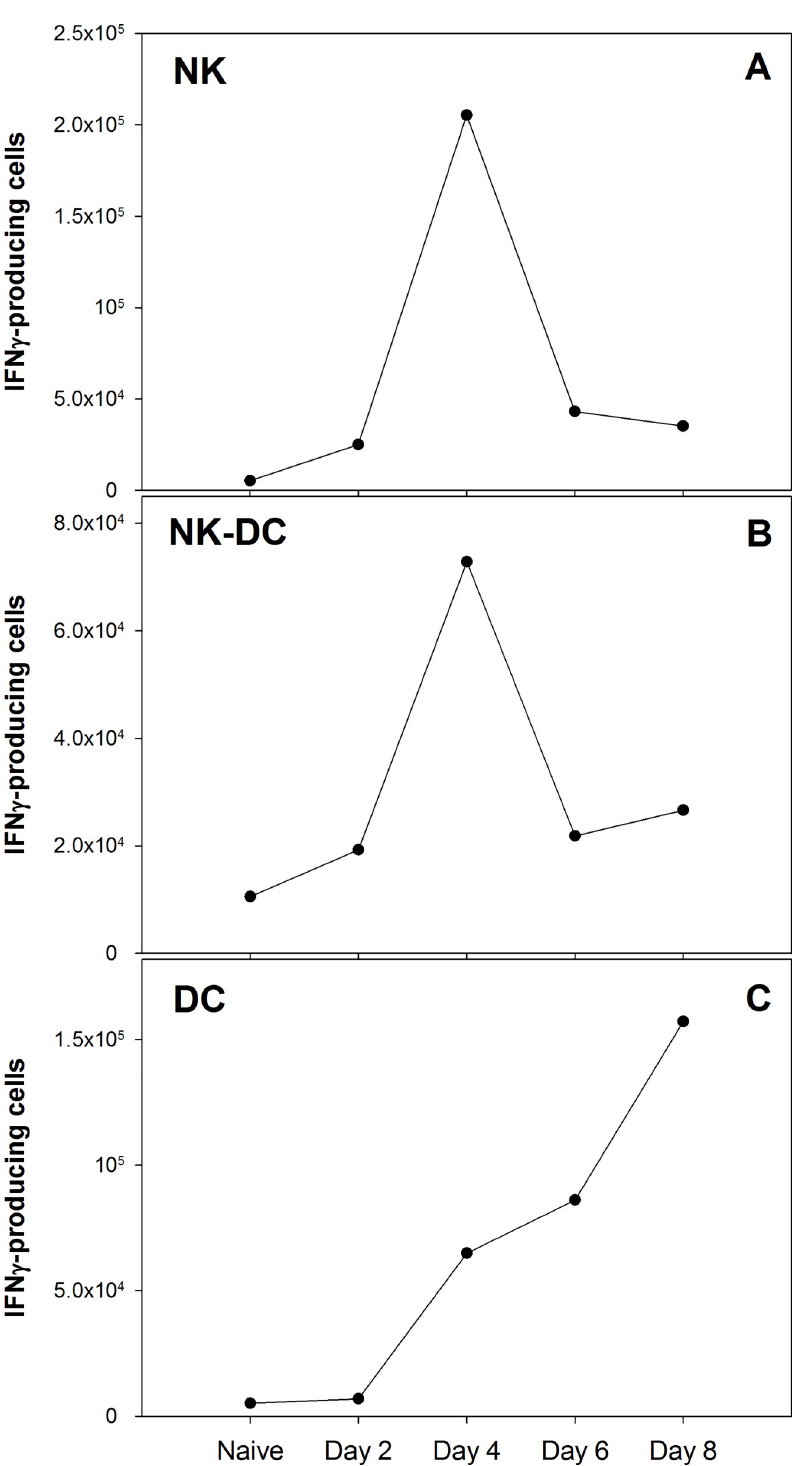
Fig 3. IFN- γ production by DC and NK subpopulations varies over time after Ft LVS infection. C57BL/6 mice were infected with 10 5 LVS. Single cell suspensions of splenocytes from LVS-infected C57BL/6 mice were prepared and analyzed by flow cytometry at days 2, 4, 6, and 8 after infection. Splenocytes from non-infected mice served as a negative control (na ï ve). After exclusion of fragments, aggregates, and dead cells, IFN- γ producing non-B non-T cells were quantified according to surface markers coupled with ICS. DC were identified as CD11c + MHCII + NK1.1 - B220 -